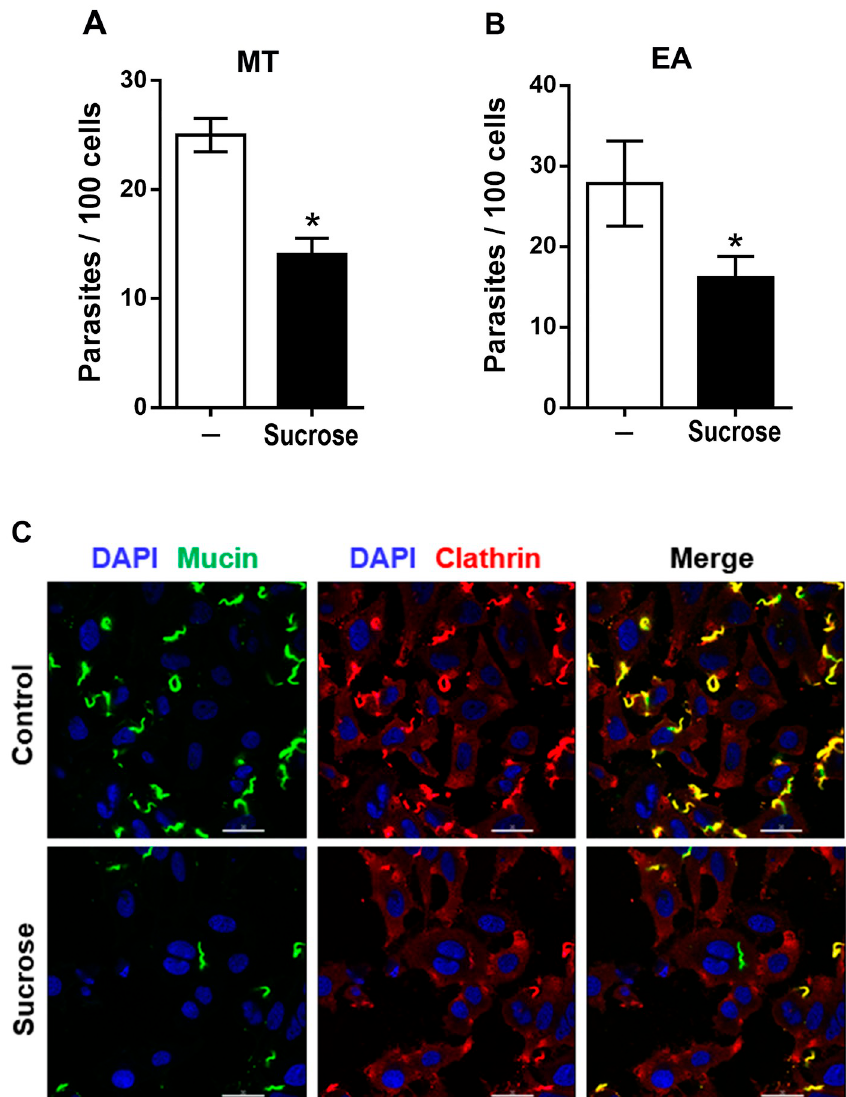
Fig 7. Inhibition of G strain MT invasion by pretreatment of host cells with sucrose. ( A ) HeLa cells were treated for 30 min with 0.45 M sucrose in serum-free medium, washed and incubated with: ( A ) G strain MT in PBS ++ or ( B ) G strain EA in R10. After 1 h, the cells were processed for intracellular parasite quantification. Values are the means ± five independent assays. HeLa cells pretreated with sucrose were significantly more resistant to invasion by MT ( � P < 0.0001) or EA ( � P < 0.005). ( C ) Untreated and sucrose-treated HeLa cells were incubated for 30 min with MT and processed for immunofluorescence microscopy, using anti-clathrin antibody and mAb 10D8. The images show clathrin (red), parasite mucins (green) and nucleus (blue). Scale bar = 30 μ m. containing mAb 3F6 or mAb 5E7 that does not recognize live MT, at 1:100 dilution, and then were incubated for 1 h with HeLa cells. Quantification of intracellular parasites showed a sig- nificantly augmented invasion capacity of MT pretreated with mAb 3F6 (Fig 9A). In addition, an experiment with purified mAb 3F6 was performed. Parasites were pretreated for 30 min with mAb 3F6, at two different concentrations, and then used for invasion assay. A significant increased MT invasion resulted upon incubation of parasites with mAb 3F6 at 200 μ g/ml (Fig 9B). The effect of recombinant gp82 protein (r-gp82), prepared as detailed [21], was also